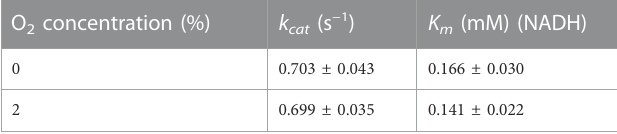
TABLE 2 Kinetic parameters of RcFDH under presence of O 2 or not.